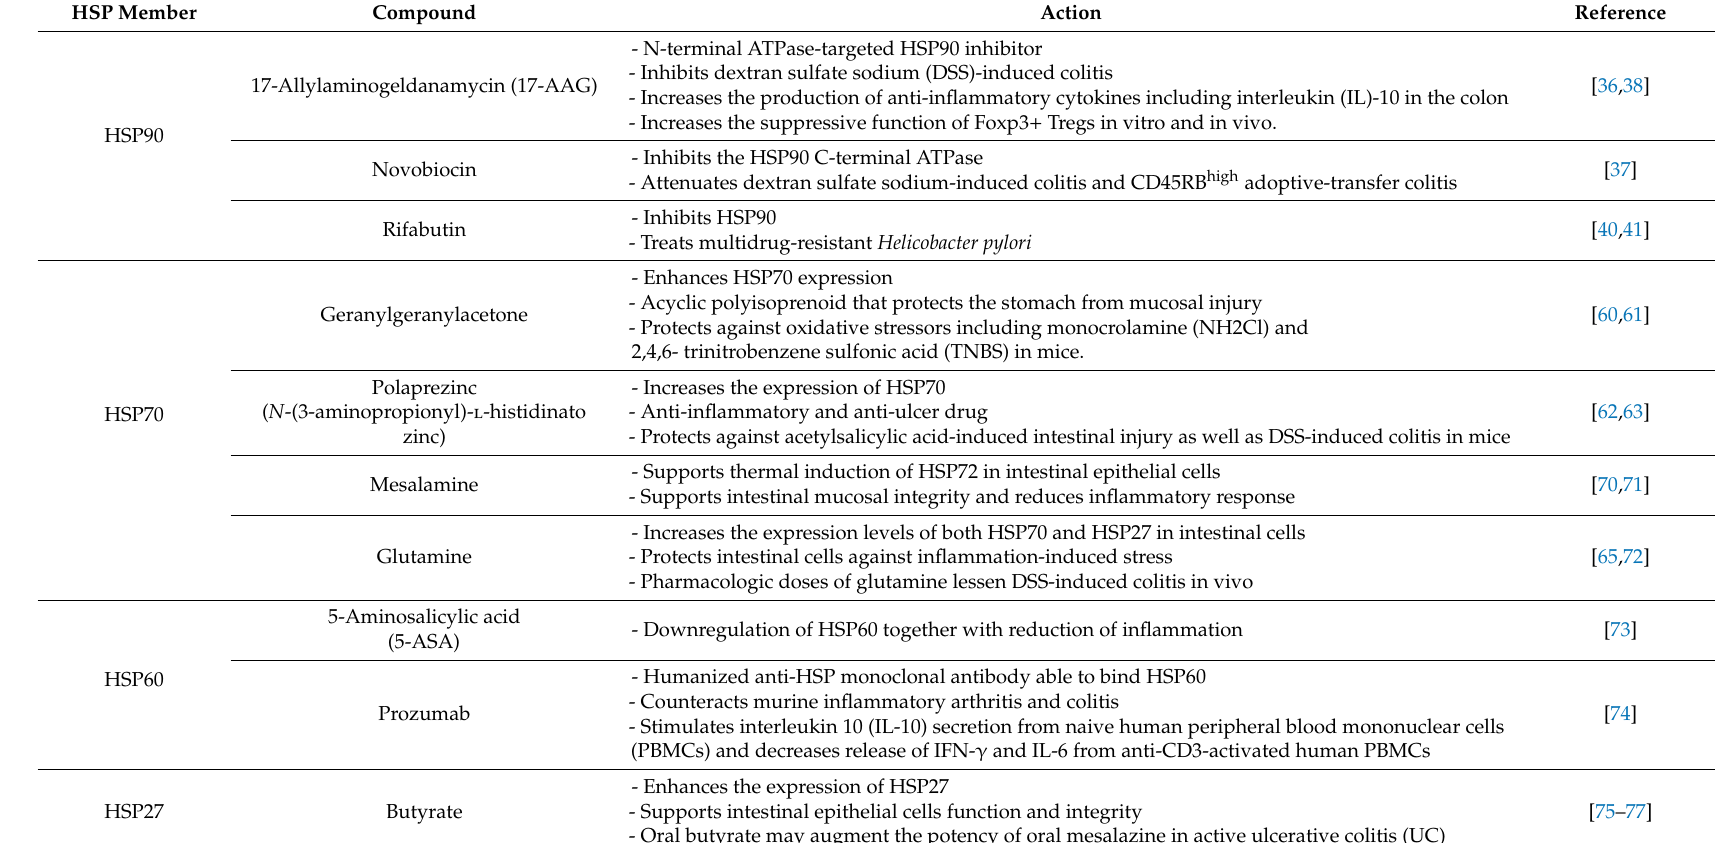
Table 2. Modulators of HSPs as a therapeutic strategy in preclinical and clinical studies of